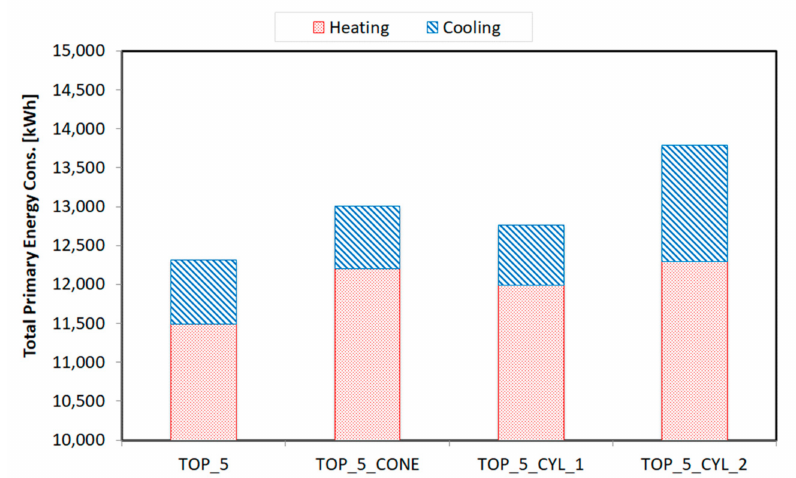
Figure 11. Primary energy consumption for the alternative developed solutions.